Question: Name the type of graph shown.
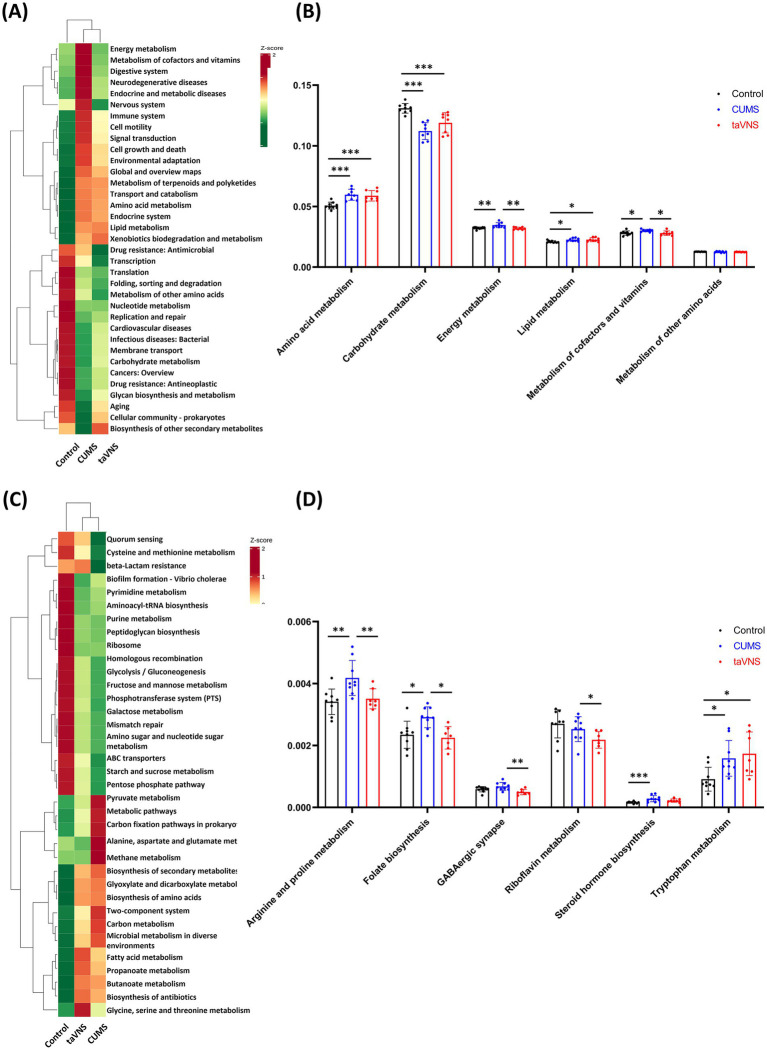
Answer: heatmap